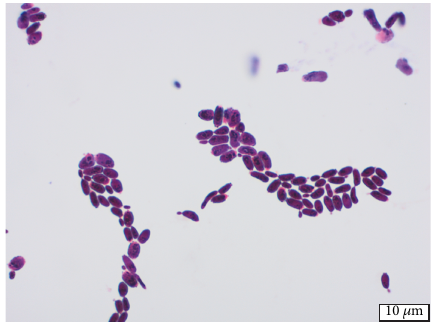
Figure 3: Gram stain of Candida parapsilosis at 1000x magni fi